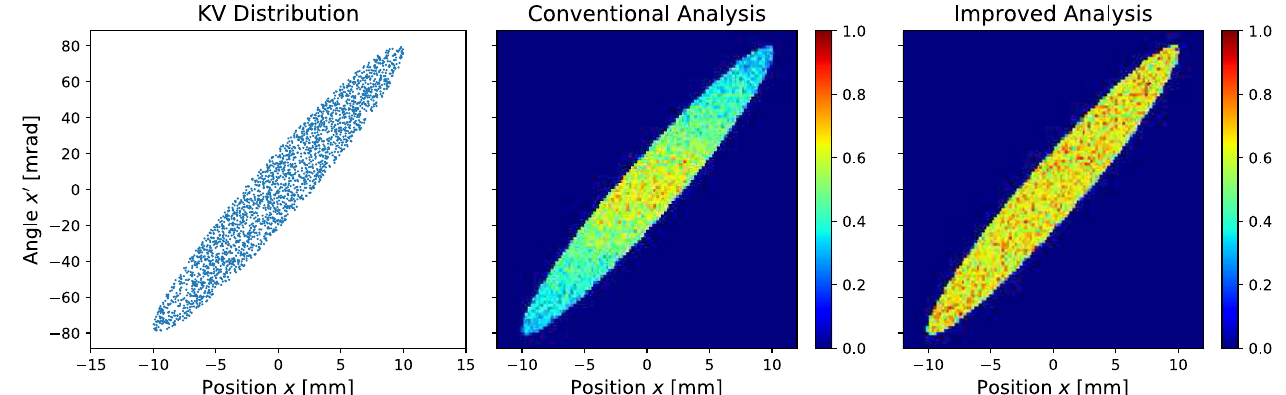
FIG. 7. Uniform phase space projection of the KV distribution, compared against results of synthesized measurement data analyzed using conventional and improved analysis methods. The left plot shows a sampling (1 out of 1000 particles) used to represent the distribution. The middle and right plots are fine mesh density plots with the same color scale.